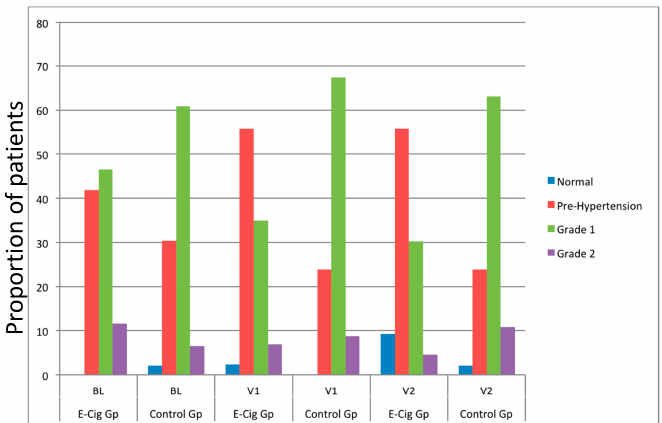
Figure 2. Proportion of blood pressure grading at baseline, visit 1 (6 ± 1 months) and visit 2 (12 ± 2 months) separately for electronic cigarettes users and controls. (Normal, blue; Pre-Hypertension, red; Grade 1, green; Grade 2, purple). Abbreviations: BL—baseline; V1—Follow-up visit 1; V2—Follow-up visit